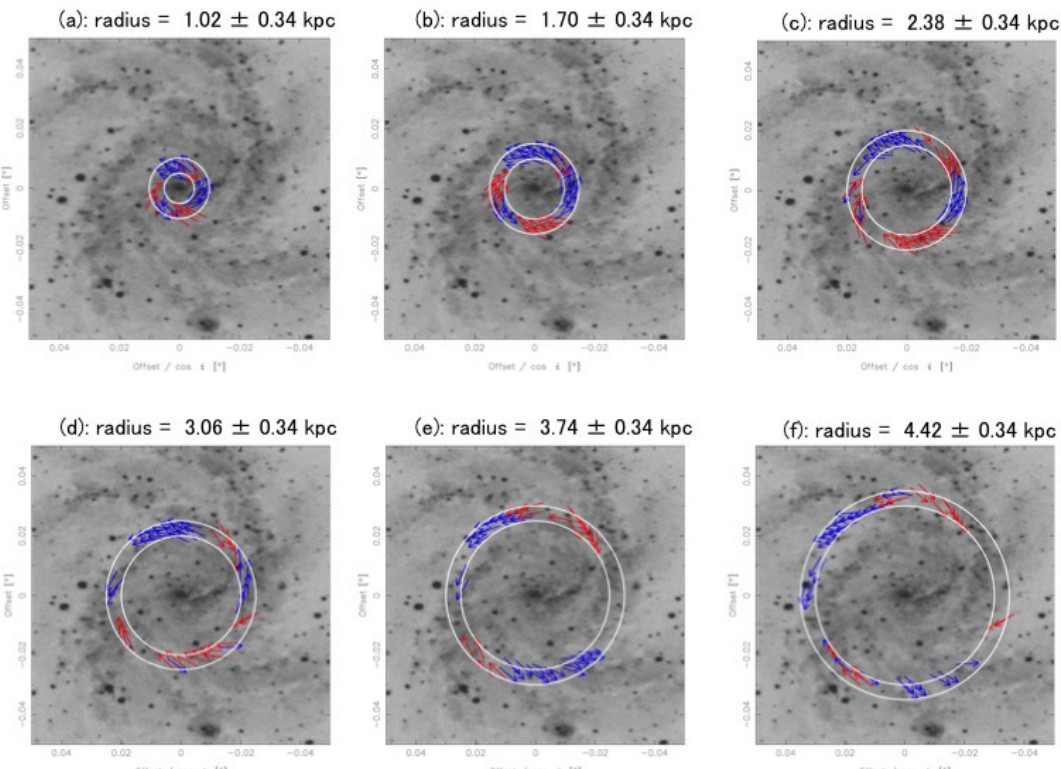
Figure 7. Face-on views of the magnetic vector maps of radius ranges of ( a ) 1.02 ± 0.34 kpc, ( b ) 1.70 ± 0.34 kpc, ( c ) 2.38 ± 0.34 kpc, ( d ) 3.06 ± 0.34 kpc, ( e ) 3.74 ± 0.34 kpc and ( f ) 4.42 ± 0.34 kpc overlaid on a black-and-white image from DSS2 B.